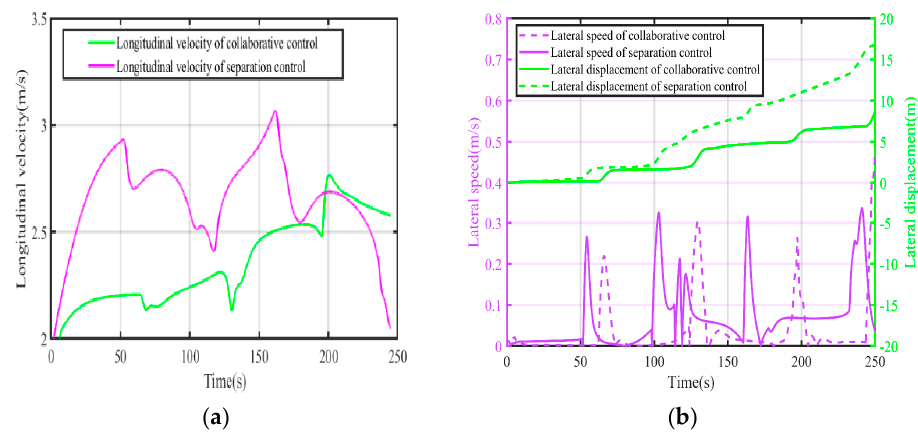
Figure 11. ( a ) Comparison curves of longitudinal velocity of four-point navigation; ( b ) Comparison of lateral speed and side lateral displacement of four-point navigation.